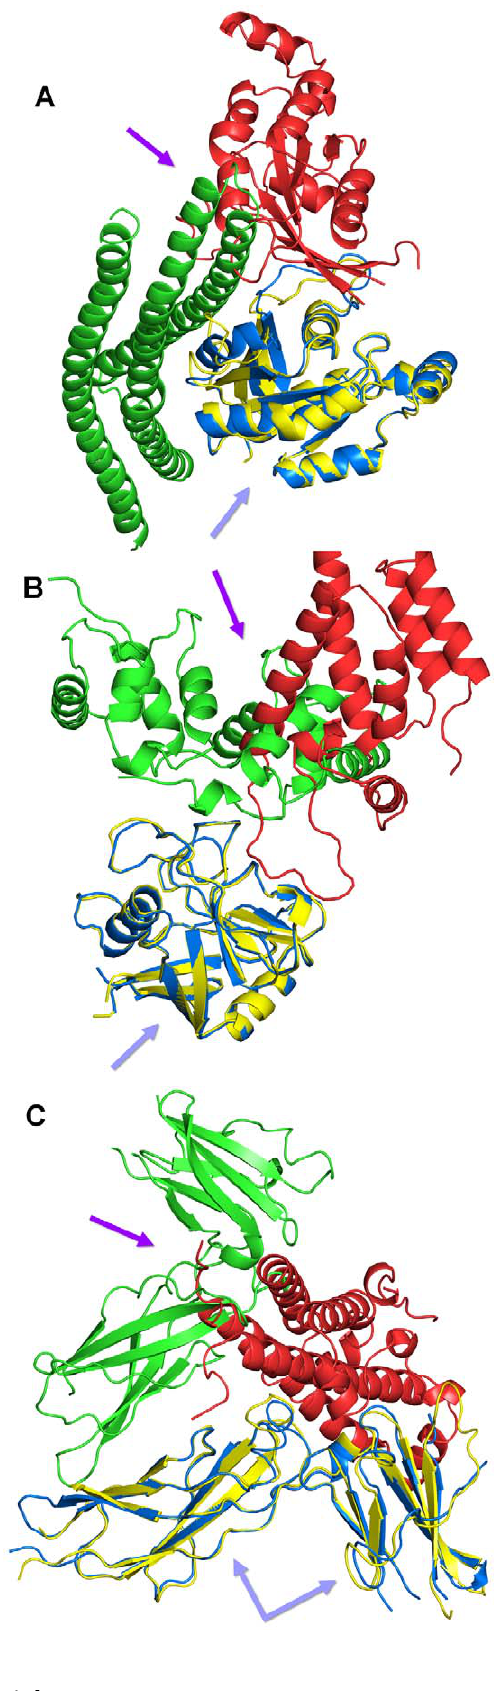
Table S1 List of colliding protein interaction pairs. Table S2 GO annotations of proteins. Table S3 Protein interactions with single-domain inter- face.